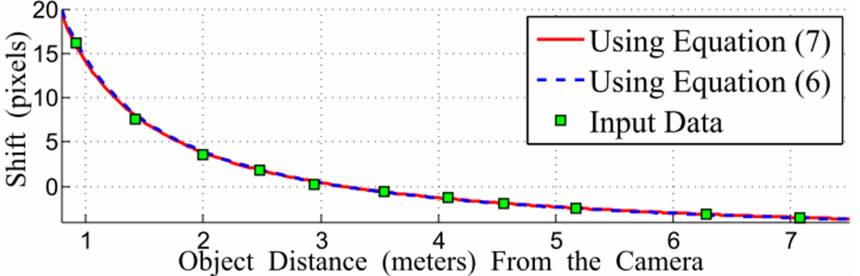
Figure 7. Plot of ∆ x versus the distance Z of an object from the camera ( f = 49 . 8 mm, z = 3250 mm, c = − 10 0 z